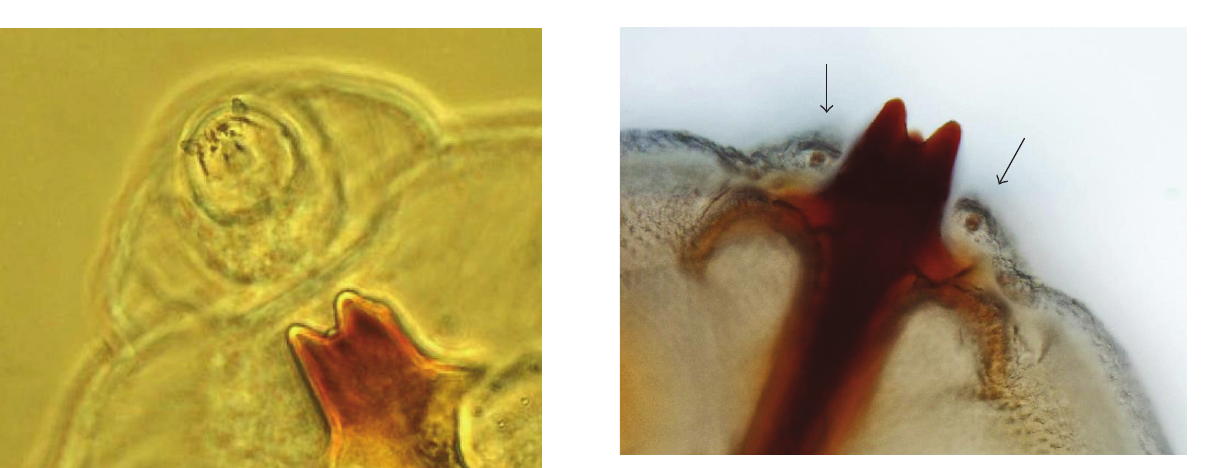
Figure16:Thethree-prongedspatulaisflankedbyfleshypadswhere the apodemes insert. The sternal papillae are seated between the spatula and the neck segment, one on each side (arrows).